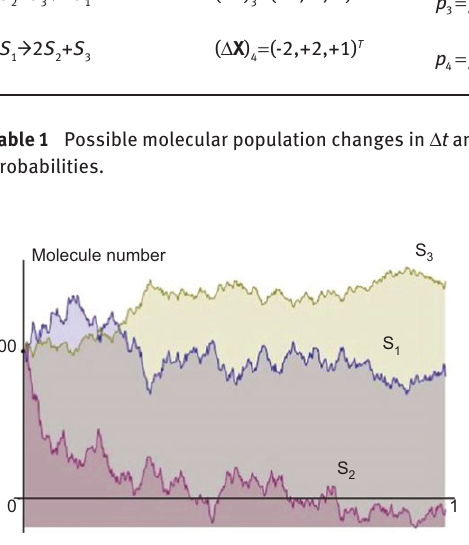
Figure 6 Molecular population numbers for one simple